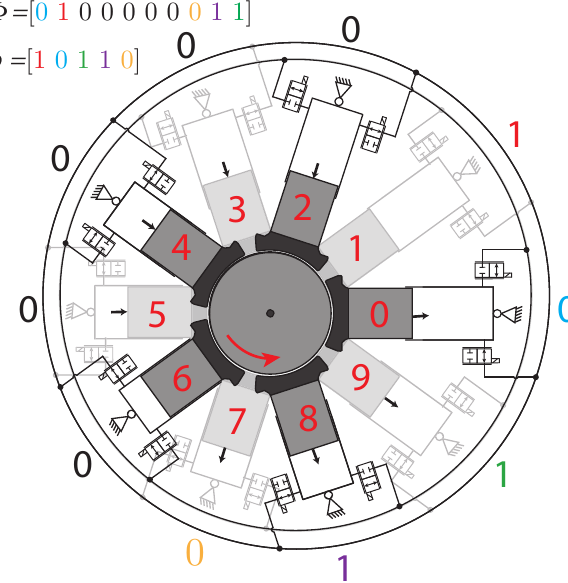
Figure 4: Combinations of discretized displacement fraction.